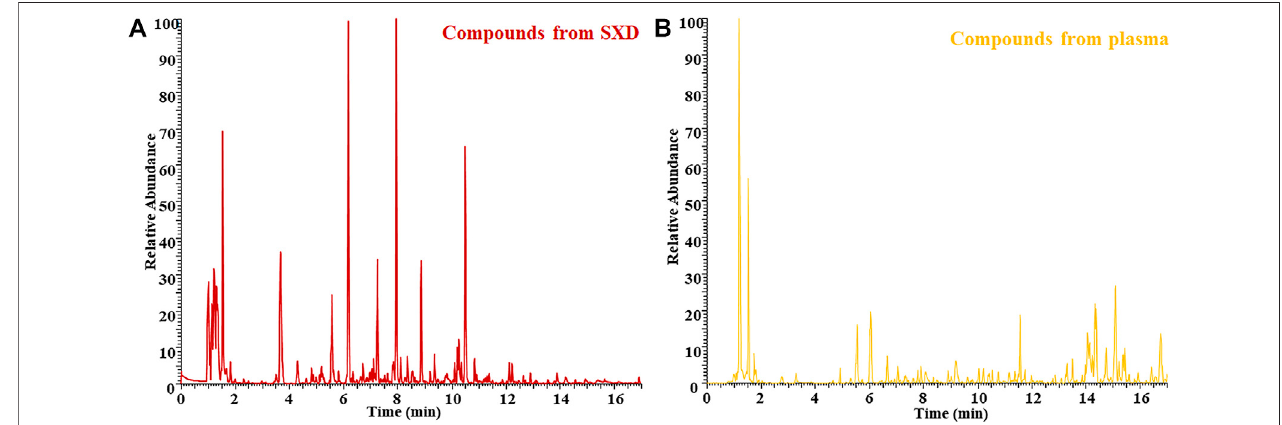
FIGURE 3 | Mapping map of drug-derived component absorbed into blood from Shuangxia decoction. Red dots represent compounds in Shuangxia decoction, yellow dots represent all compounds in plasma after administration of Shuangxia decoction, and green dots represent compounds common to both samples (A) ; distributionmapofmassspectruminformationofallabsorbedbloodcomponentsfromShuangxiadecoction, thechromatographicretentiontimeandm/zvalueofeach compound are presented on the coordinate axis, and the relative normalized value is expressed by the size of the bubble (B) ; the Venn diagram of all absorbed blood components. A total of 7,404 compounds were found to have been absorbed into the blood by mass spectrometry data intersection between the freeze-dried Shuangxia decoction and the plasma samples of rats treated with Shuangxia decoction (C) .